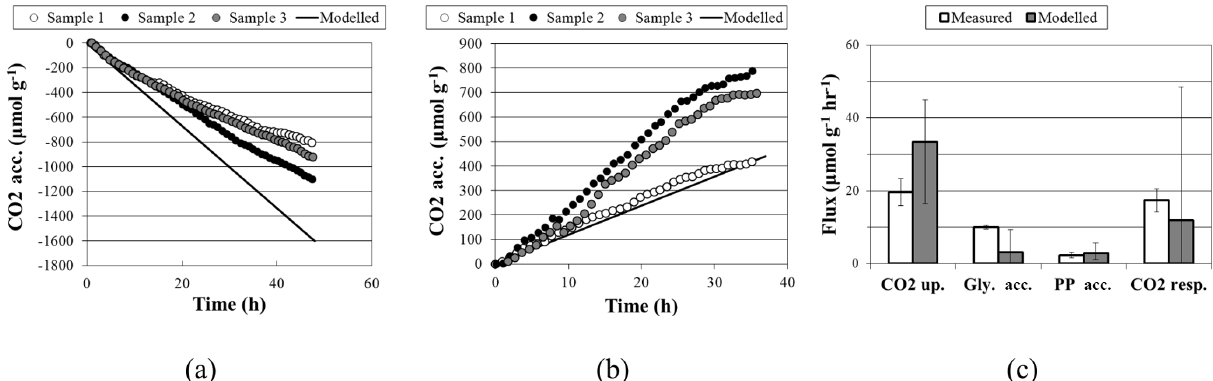
Figure 2. Comparisons of experimental and modeled CO 2 accumulation (a) in the light, where a negative value indicates uptake, and (b) in the dark, where a positive value indicates respiration. Biopolymer and CO 2 flux rates are compared in (c) , where error bars on modeled flux rates are the upper and lower bounds determined through sensitivity analysis; error bars on measured flux rates are standard deviations. Table 3. Experimental and modeled flux values over light and dark conditions. Constraint fluxes are noted with a “ ∗ ”. Negative and positive CO 2 fluxes represent uptake and respiration, respectively, while negative and positive biopolymer flux rates represent depletion and accu- mulation, respectively. Measured “ − ” and “ + ” refer to the standard deviation. Modeled “ − ” and “ + ” refer to the upper and lower values obtained from sensitivity analysis. In modeled constraint reactions for light, “ − ” and “ + ” represent the assumed deviation that is input into sensitivity analysis. Measured Modeled